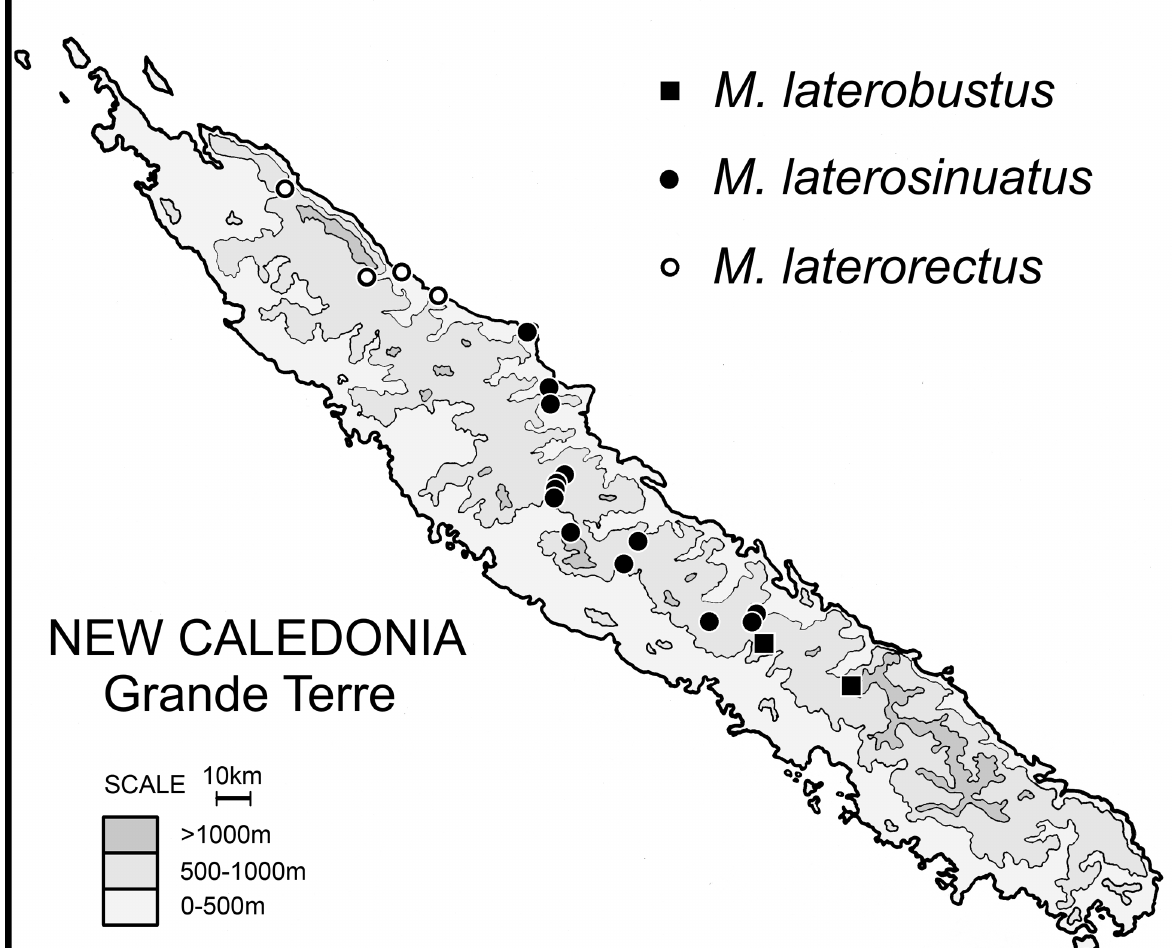
Figure 14. Geographical distributions of Mecyclothorax ( Phacothorax )